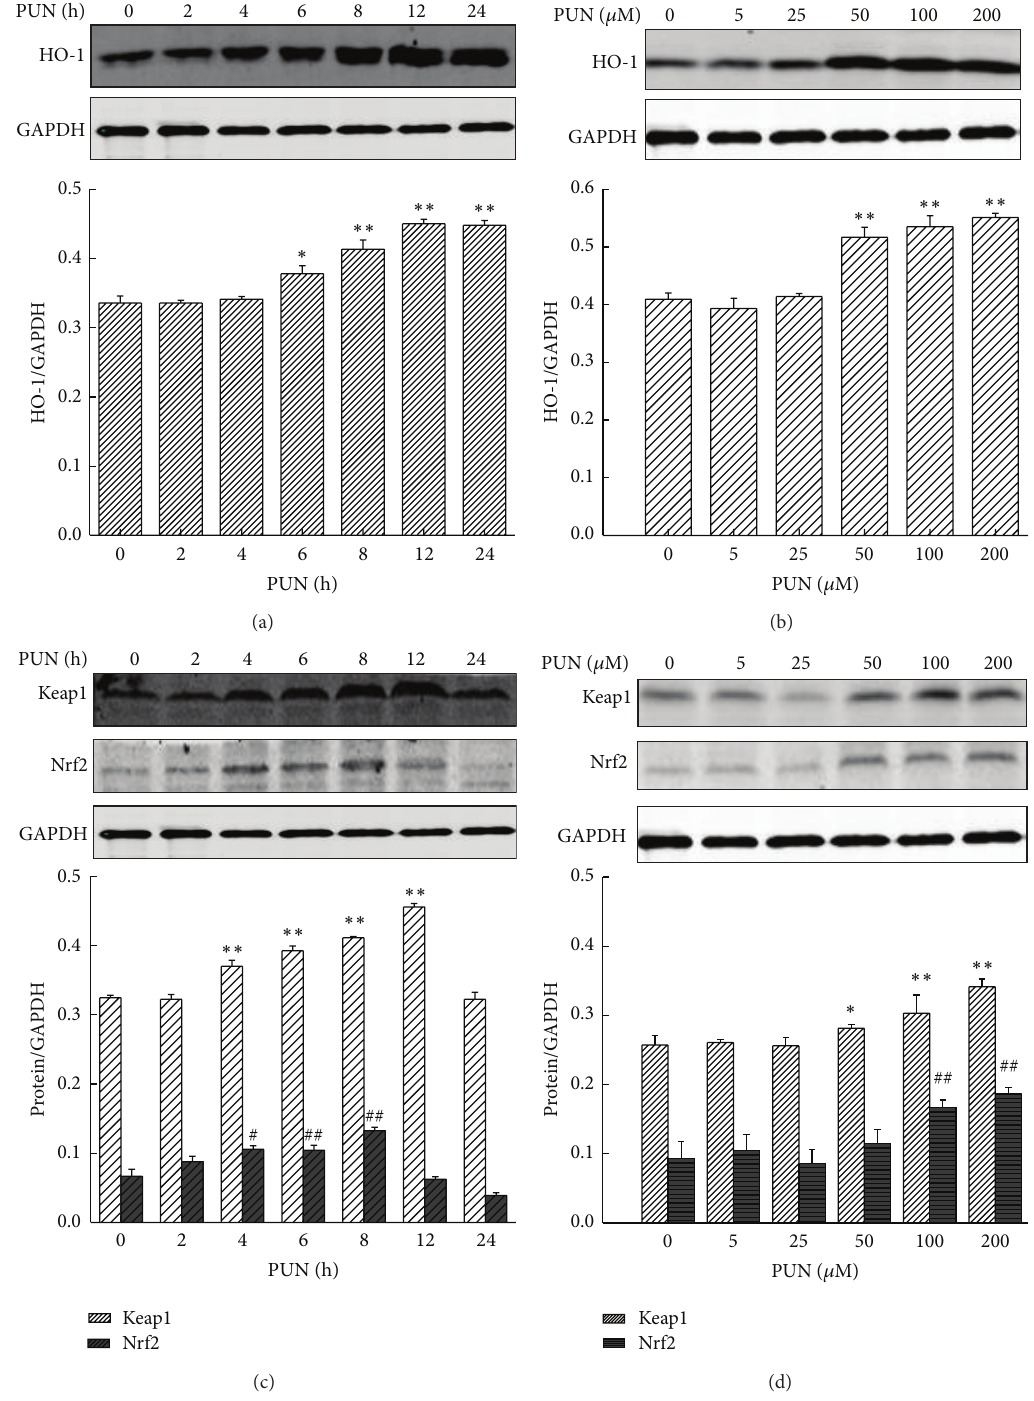
Figure 1: PUN increases Nrf2/HO-1 expression in RAW264.7 cells in time-dependent manner and dose-dependent manner. Cells were incubated at 37 ∘ C in a humidified incubator with 5% CO 2 . (a) RAW264.7 cells were treated with 100 𝜇 M PUN for indicated durations (0, 2, 4, 6, 8, 12, and 24 h). The HO-1 protein expression was analyzed by Western blotting. (b) RAW264.7 cells were treated for 8 h with PUN at the indicated concerntrations (0, 5, 25, 50, 100, and 200 𝜇 M). The HO-1 protein expression was analyzed by Western blotting. (c) RAW264.7 cells were treated with 100 𝜇 M PUN for indicated durations (0, 2, 4, 6, 8, 12, and 24 h). The Nrf2 and Keap1 protein expression were analyzed by Western blotting. (d) RAW264.7 cells were treated for 8 h with PUN at the indicated concerntrations (0, 5, 25, 50, 100, and 200 𝜇 M). The Nrf2 and Keap1 protein expression were analyzed by Western blotting. Data represent the mean ± SEM of three independent experiments and differences between mean values were assessed by one-way ANOVA. ∗ 𝑃 < 0.05 , ∗∗ 𝑃 < 0.01 , # 𝑃 < 0.05 , and ## 𝑃 < 0.01 indicate significant differences compared with the control group of indicated proteins,